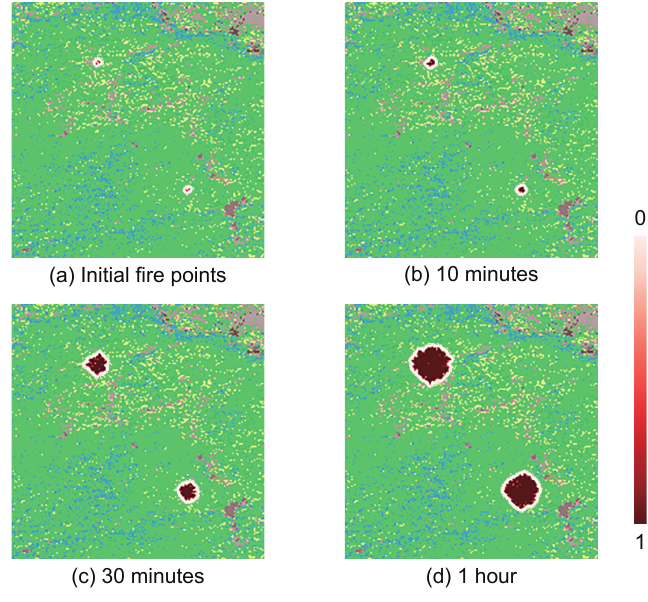
Figure 8. Forest fire simulation